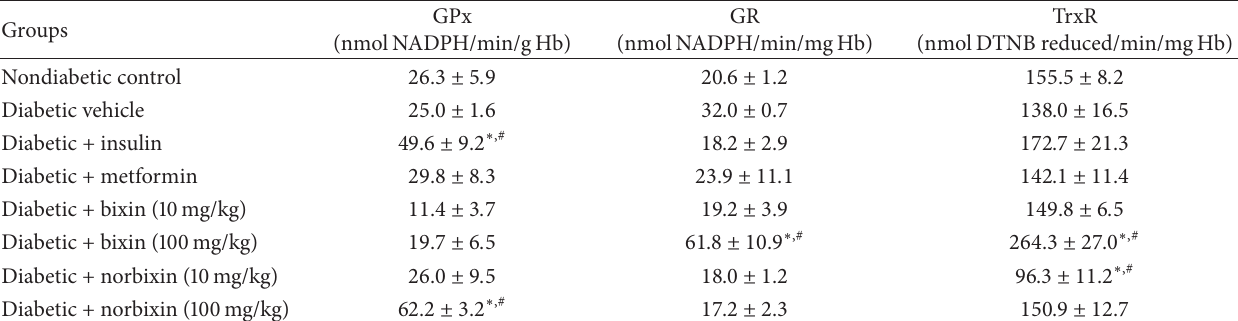
Table 1: Effect of bixin and norbixin treatment on oxidative stress parameters in the blood of streptozotocin-induced diabetic rats.